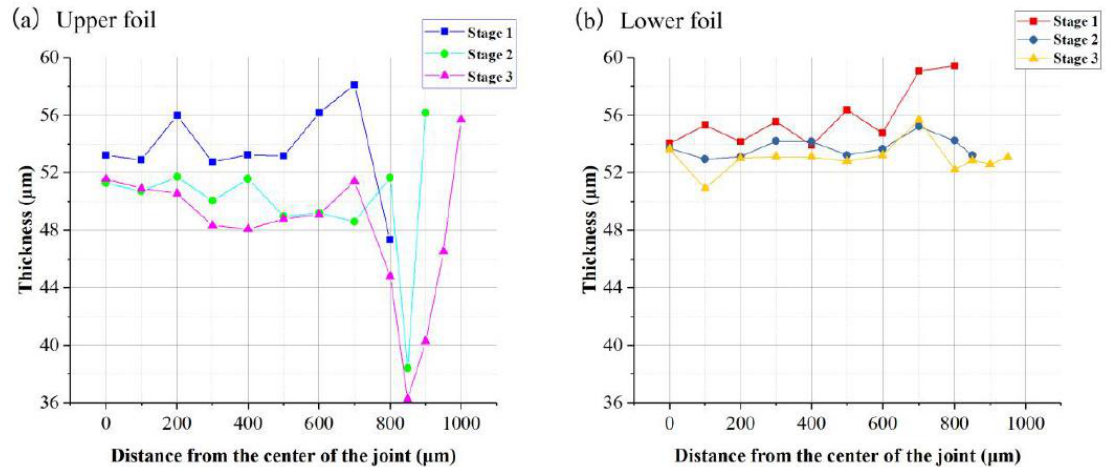
Figure 15. The B–B section thickness distribution curves in three stages: ( a ) upper foil and ( b ) lower foil.